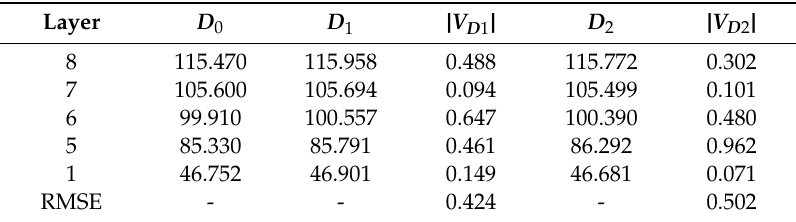
Table 1. Diameter measurement results for I 1 and I 2 . (unit: mm).